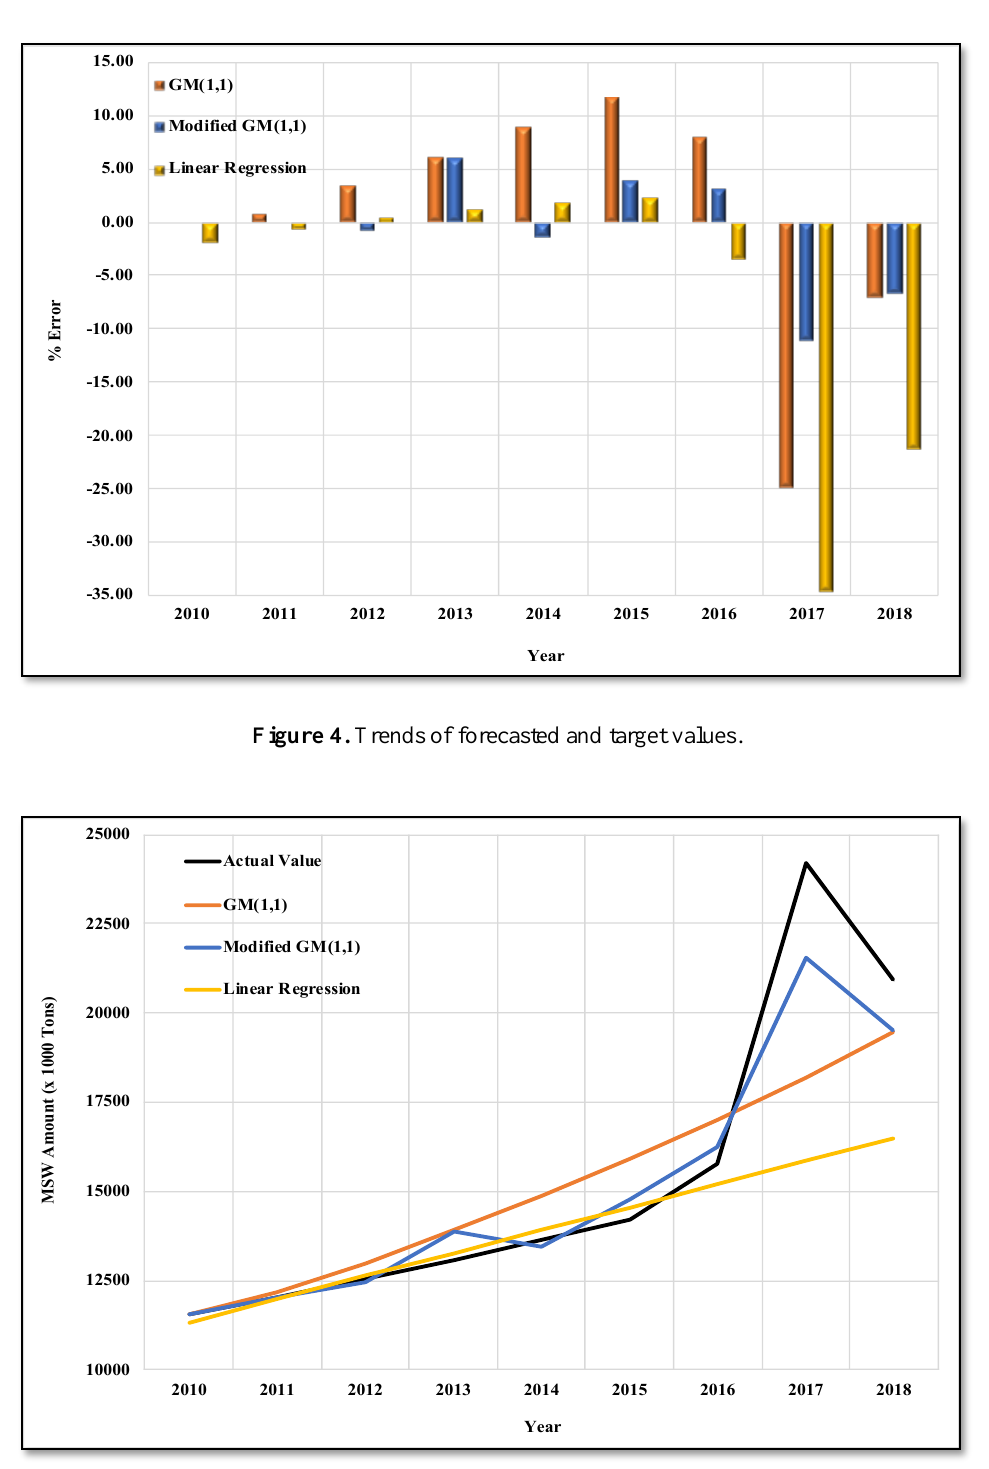
Figure 5. Distribution of forecasting percentage